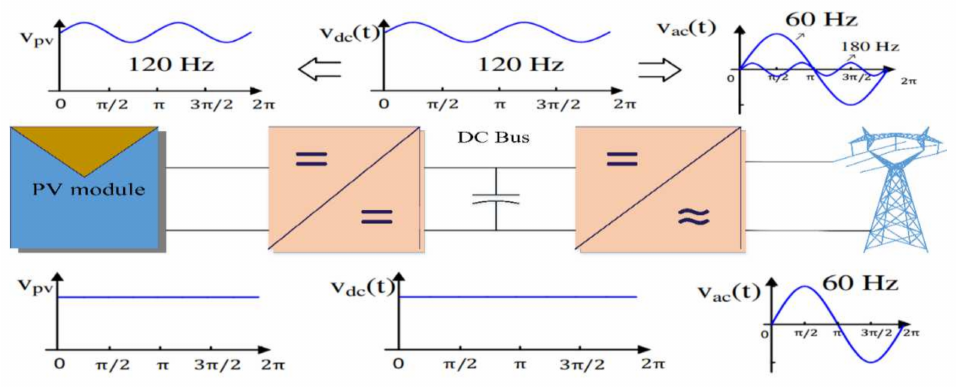
Figure 2. One phase-two stage PV DC-link capacitor power